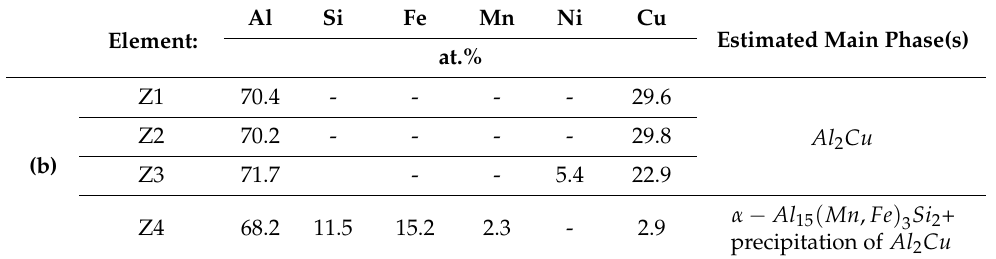
Table 5. EDS points analyses for the joint 13/680 presented in Figure